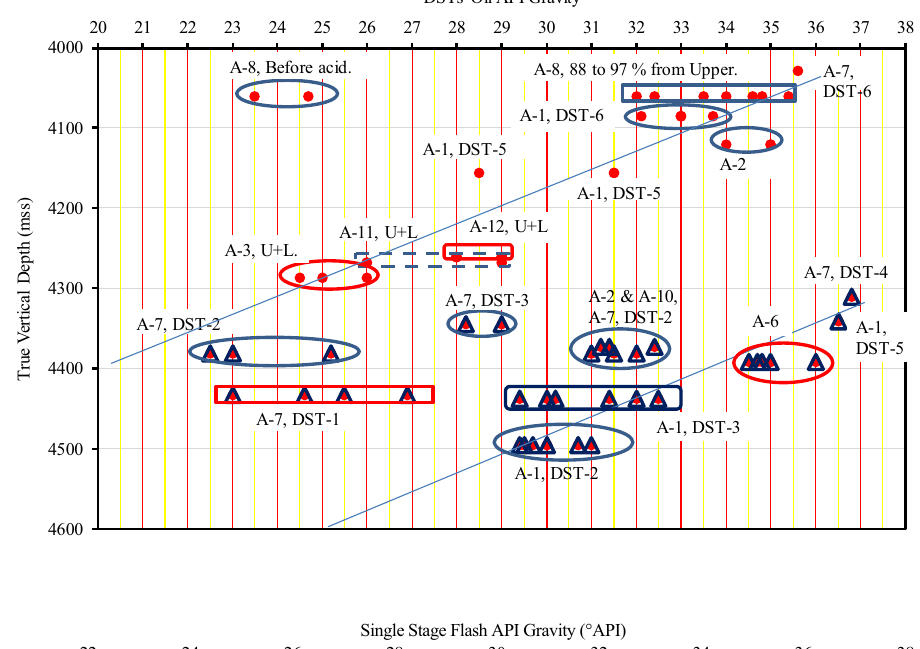
Fig. 4 Measured single stage flash API gravities of reservoir oil samples during PVT